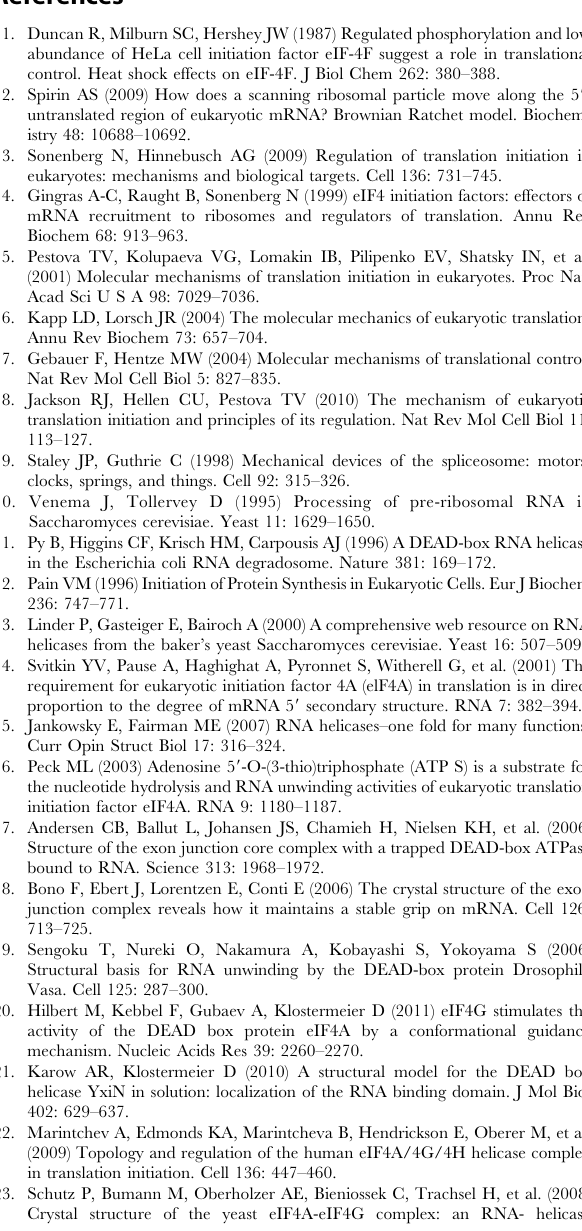
Table S1 The occupancies (%) of hydrogen bonds between the RNA and the N-domain (ND) of the eIF4A protein, for the RNA + eIF4A (RNA + 4A), I’, II’, III’, IV’ and ATP + RNA + C-eIF4A (C) models. Table S2 The occupancies (%) of hydrogen bonds between the RNA and the C-domain (CD) of the eIF4A for the RNA + eIF4A (RNA + 4A), I’, II’, III’, IV’ and ATP + RNA + C-eIF4A (C) models. Table S3 The occupancies (%) of hydrogen bonds of the interface between the N-terminal domain and C-termi- nal domain in the RNA + eIF4A (RNA + 4A), I’, II’, III’, IV’ and ATP + RNA + C-eIF4A (C)